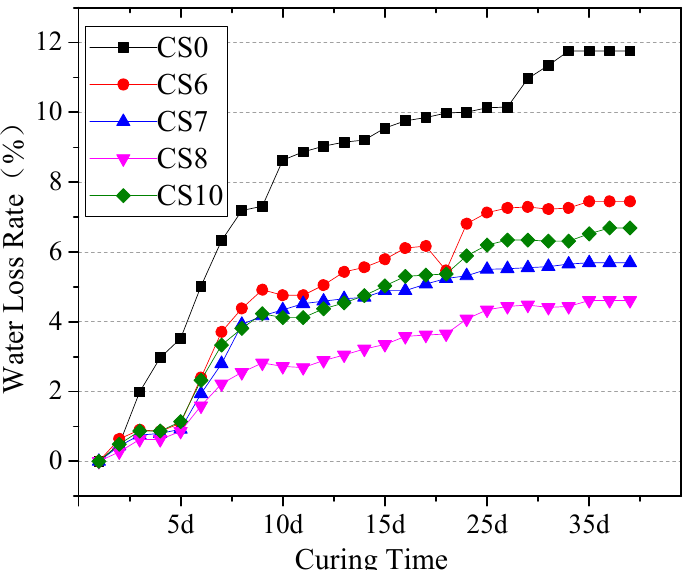
Figure 9. The water loss rate of CS0, CS6, CS7, CS8, CS10.